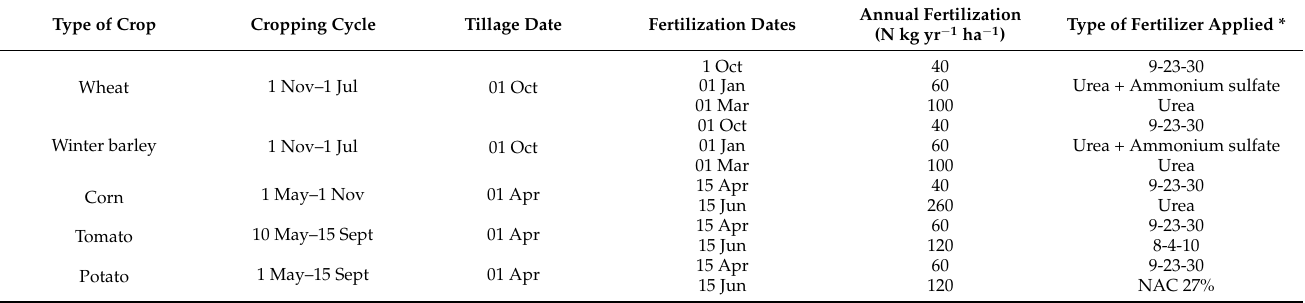
Table 1. Crop types, cropping cycle, and fertilization schedules in the Cidacos River